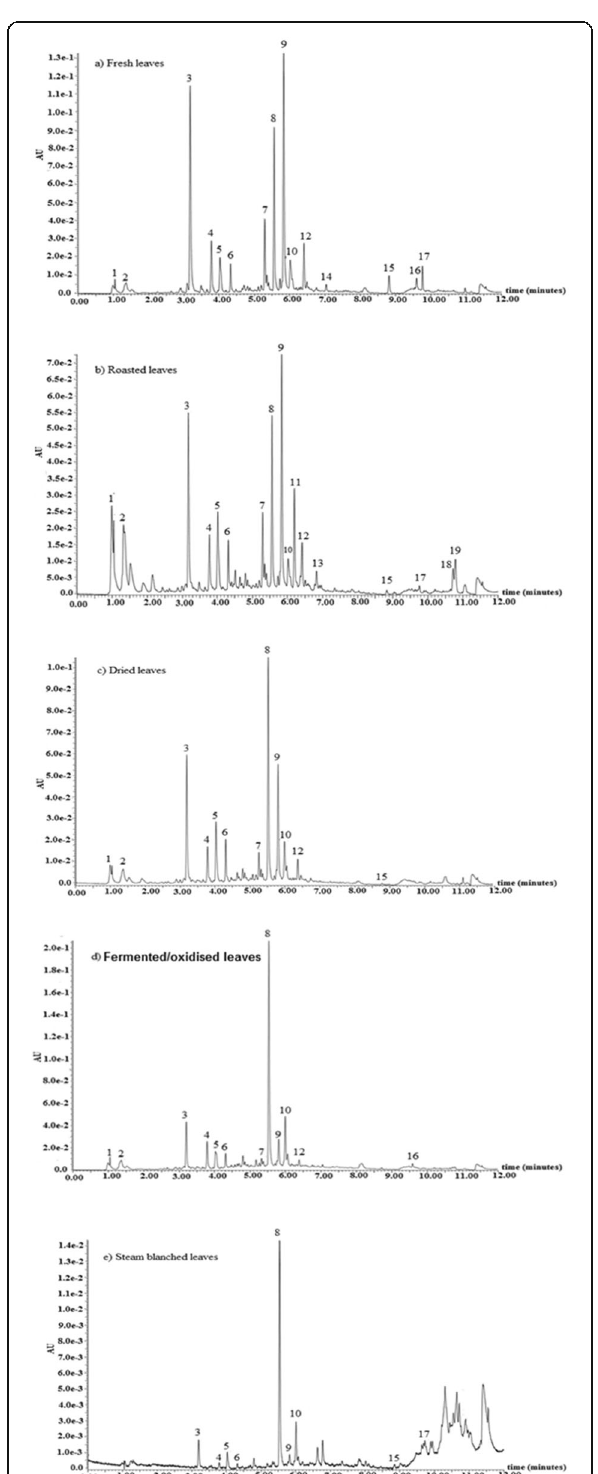
Fig. 6 LC-MS/MS phenolic profile of processed Moringa leaf extract a fresh leaves; b roasted leaves; c dried leaves; d fermented/oxidised leaves; e steam blanched